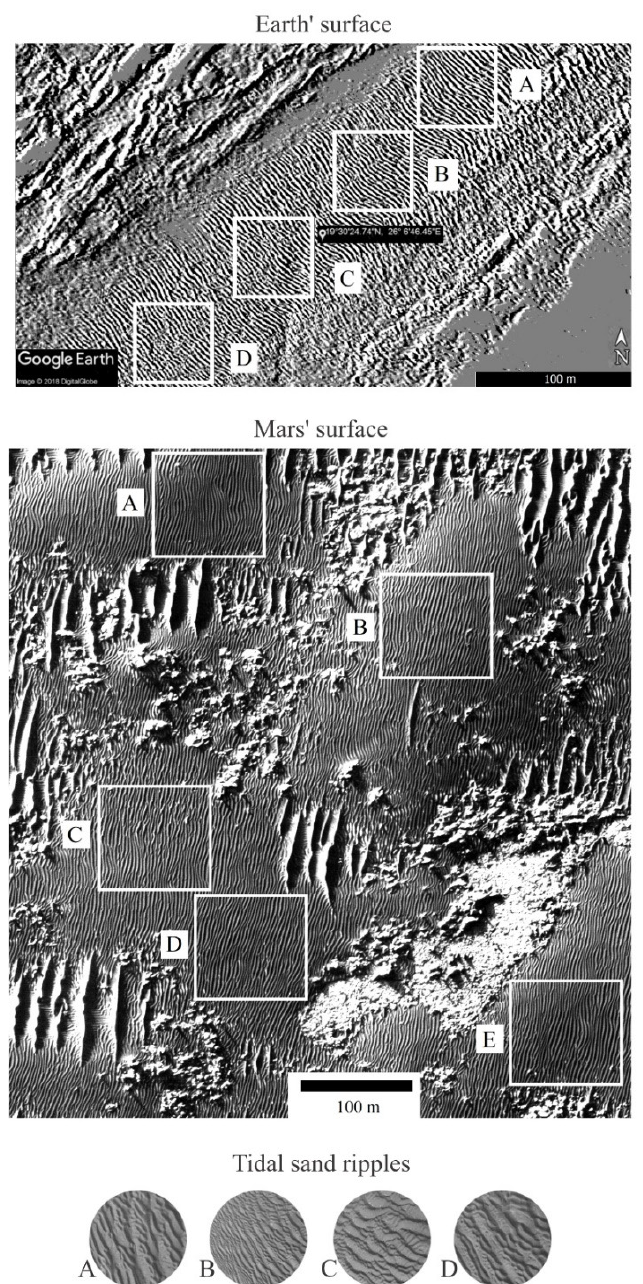
Figure 1. Test images with high edge gradient. Earth’s surface. Credit: Remote Sensing of Environ- ment [13] and Google Earth Pro. Mars’ surface. Credit: Jet Propulsion Laboratory [14]. Tidal sand ripples. Credit: Reproduced with permission from J.M. Winder [15]; https://natureinfocus.blog/20 16/09/03/inch-2// accessed on 17 January